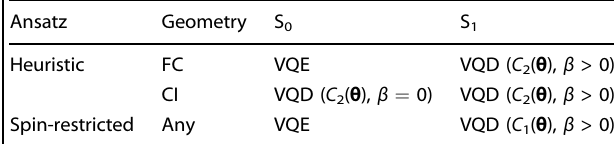
Table 1. Comparison of the calculation methods for S 0 and S 1 .